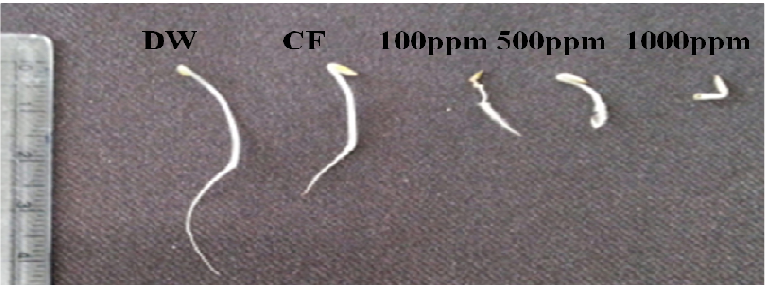
Figure 2. Inhibitory action of ethyl acetate extract obtained from CF of Cladosporium cladosporioides LWL5 at different concentration (100, 500 and 1000 ppm) on lettuce seed germination. Distilled water (DW) and culture filtrate (CF) were applied as a positive and negative control,